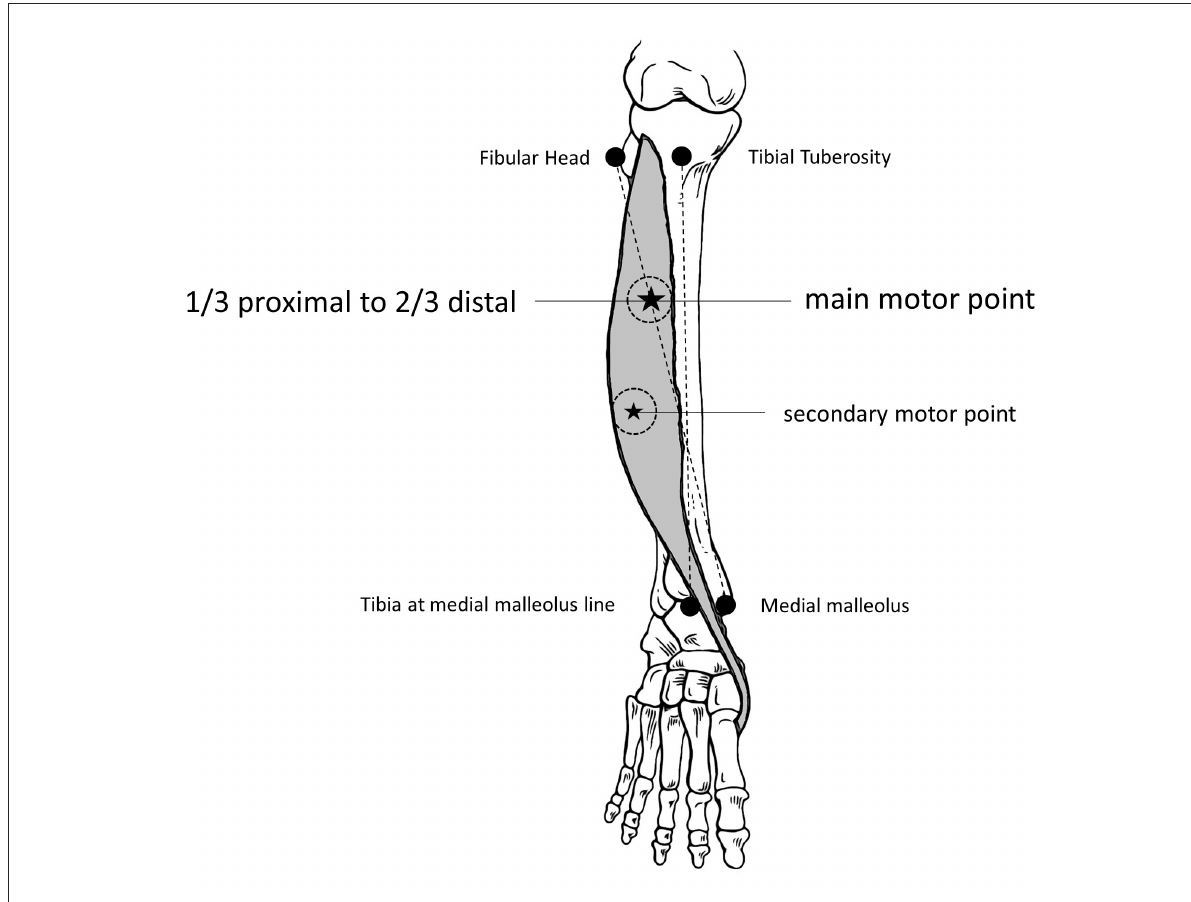
(16). The time spent on this technique was about 30min.